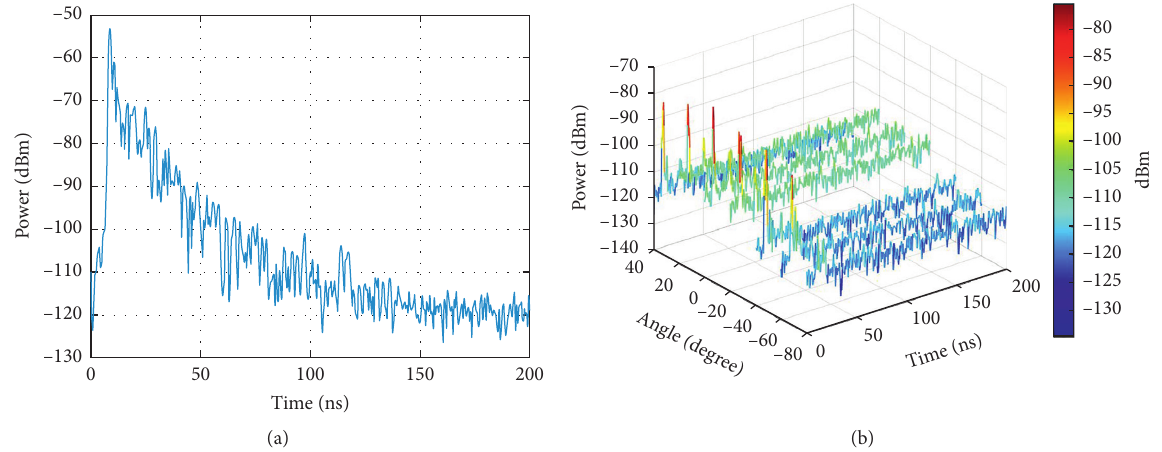
Figure 2: Power delay profile at 2.2m Tx-Rx separation distance in step 5 of the stair: (a) 3.5GHz and (b) 28GHz.